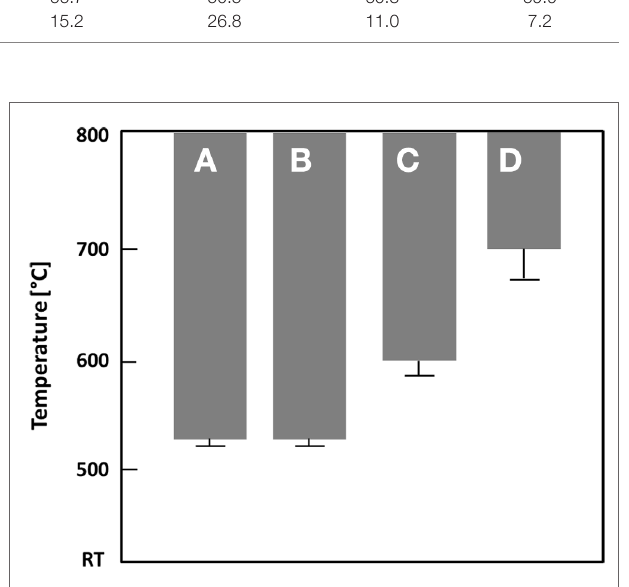
FigUre 6 | schematic summary of the phase formation sequence of li 2 si 2 O 5 (a), li 2 siO 3 (B), li 3 PO 4 (c), and ca 5 (PO 4 ) 3 F (D) as a function of crystallization temperature for glass D after nucleation at 500°c for 30 min